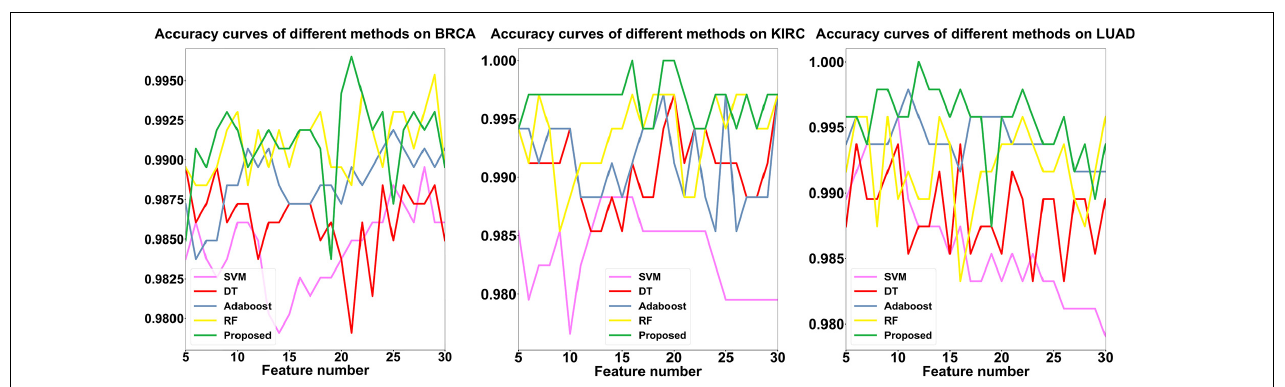
FIGURE 5 | The comparison results of SLPEE and the other four